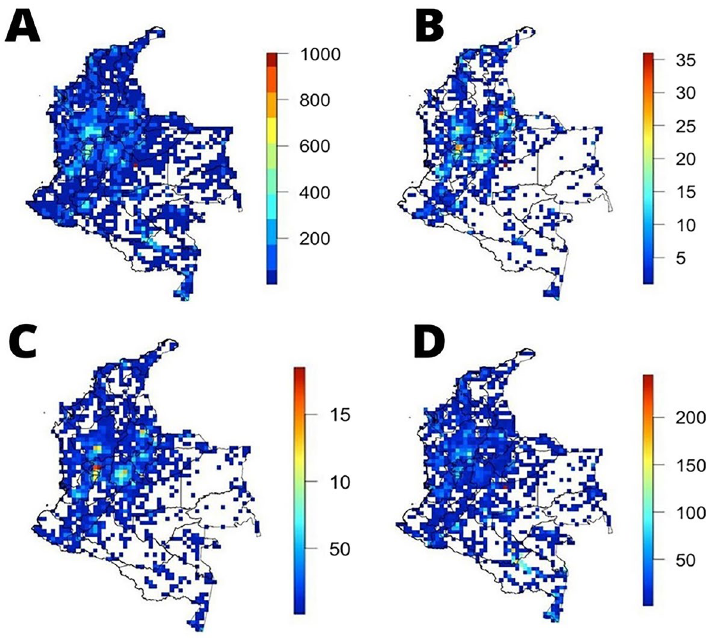
Figure 3. Distribution of Colombian edible plants by growing habit: ( A ) tree species, ( B ) shrub species, ( C ) herb species and ( D ) climbing species. The four distributions show relatively congruous trends, with high species concentrations across the Andean region. Generated in R 4.1.0. https:// www.R- proje ct.